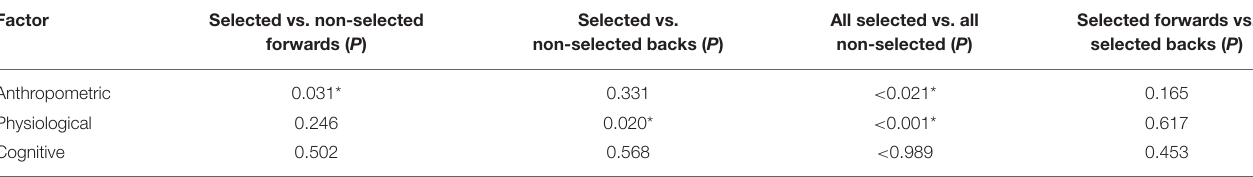
TABLE 2 | MANOVA for the anthropometric and physiological factors and ANOVA for the cognitive factor. Factor Selected vs. non-selected